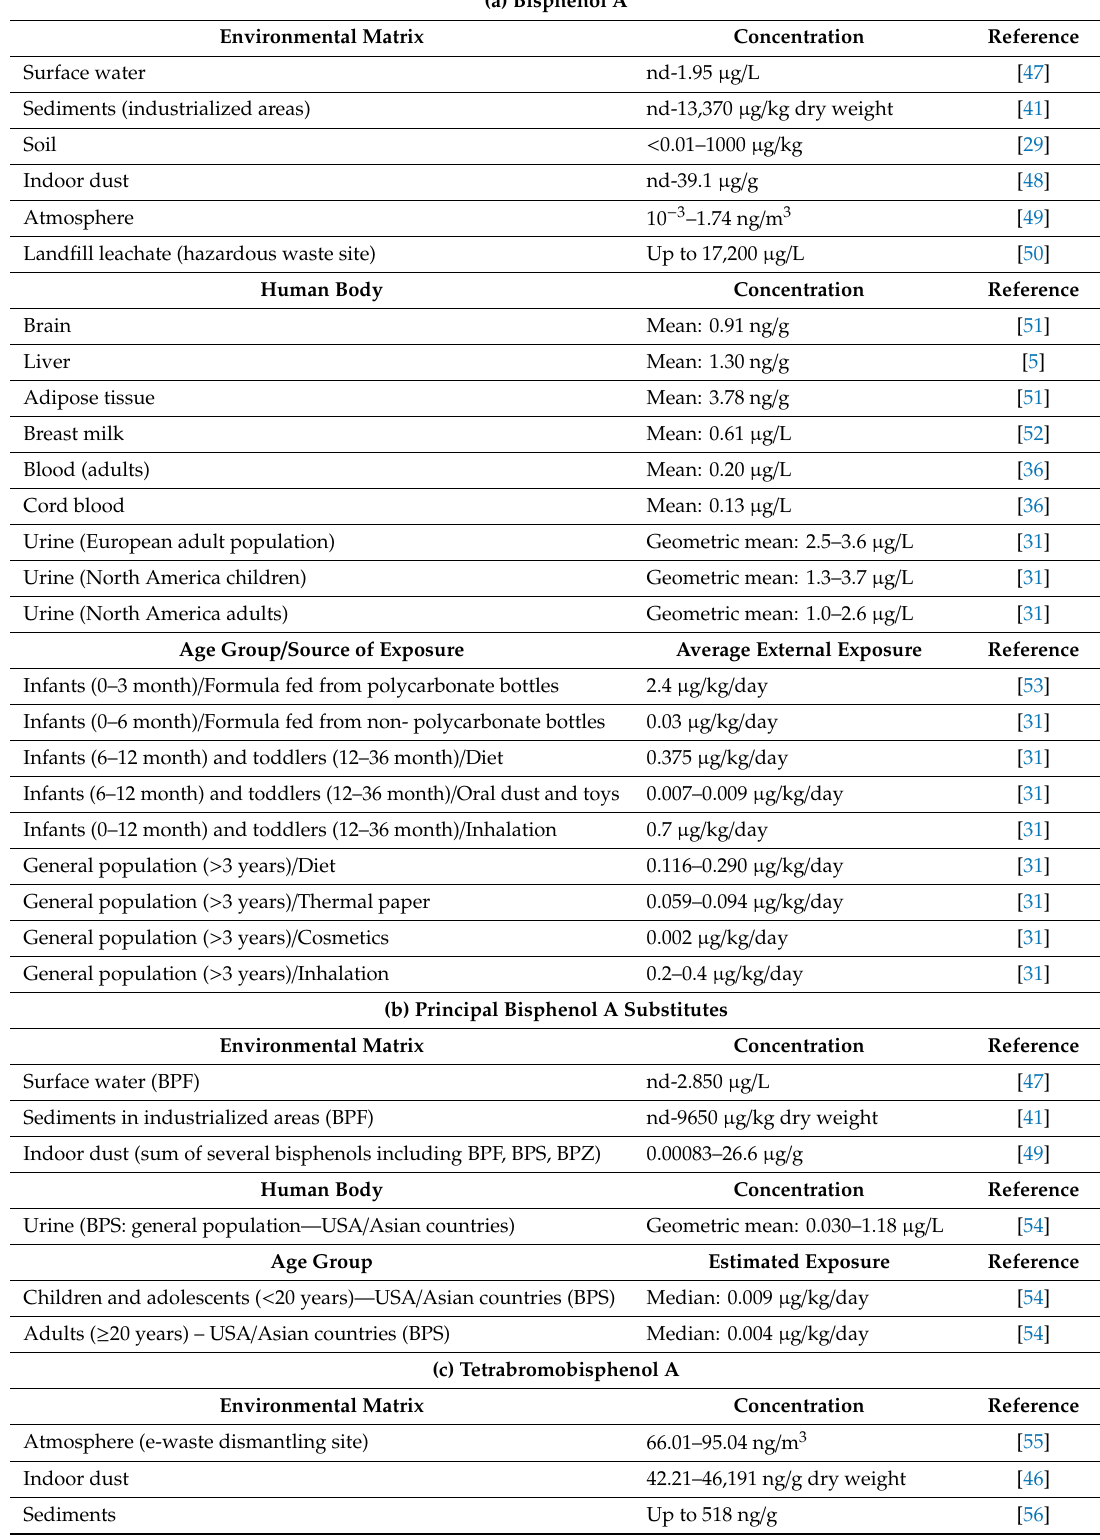
Table 1. Concentration of bisphenols in the environment and human body, and estimated exposure by age groups to bisphenol A (a), principal bisphenol A substitutes (b), and halogenated derivatives